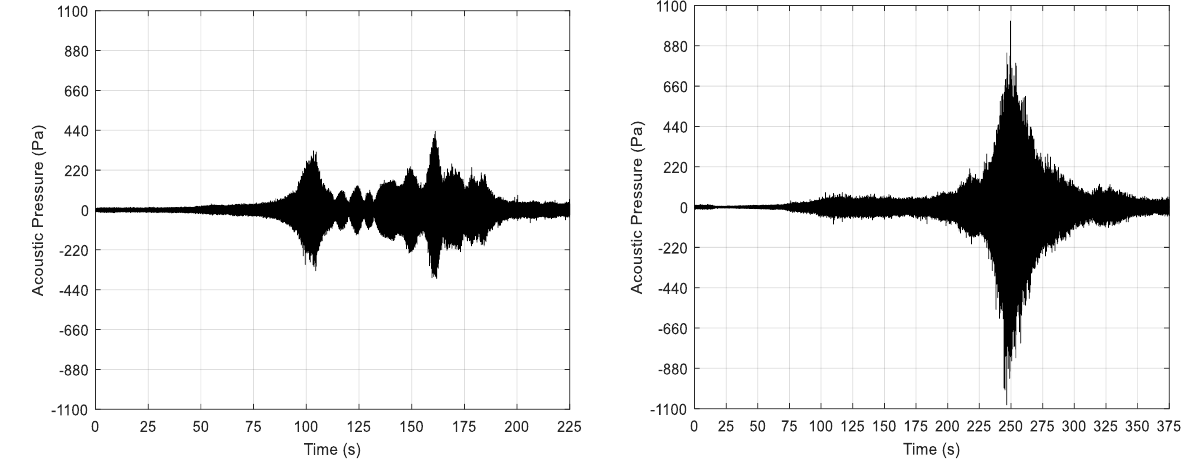
Figure 3. Time series of the amplitude (in Pa) of acoustic measurements performed while a passenger ship was passing at a minimum distance of 11 m and speed of 6.5 knots ( left ) and while a merchant ship was passing at a minimum distance of 31 m and speed of 7.1 knots ( right ). These measurements are classified as Shipping Noise Measurements.